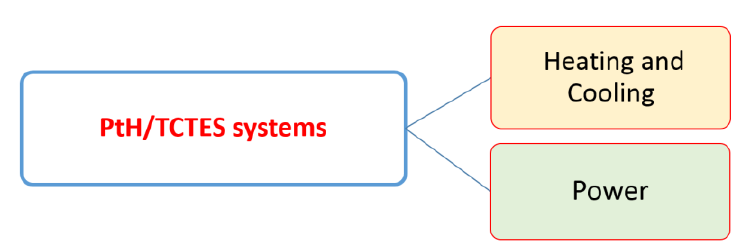
Figure 4. Thermochemical storage and power-to-heat uses.